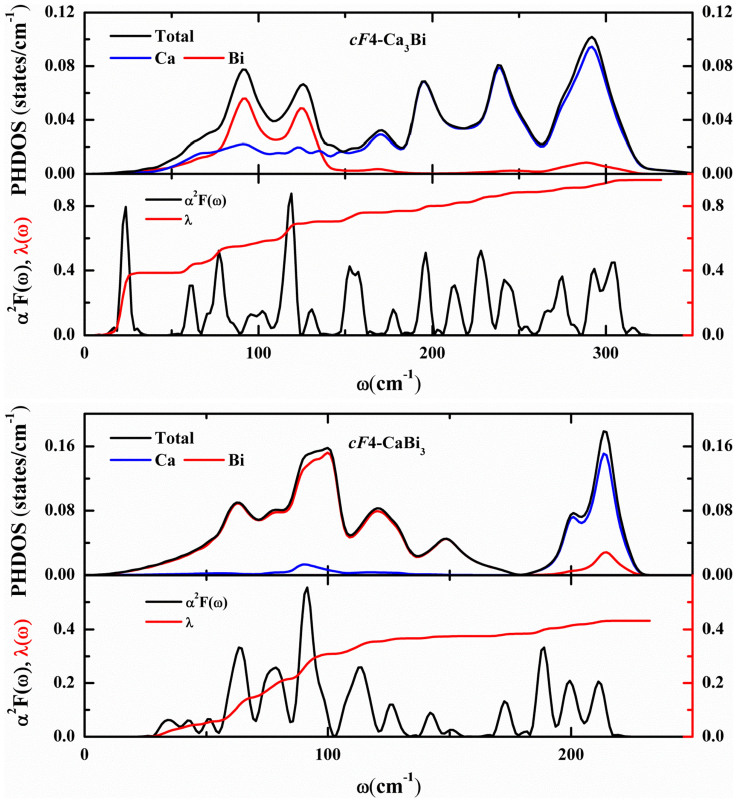
Total and projected phonon density of states (PHDOS) and Eliashberg function α2F(ω) for cF4-Ca3Bi at 60 GPa and cF4-CaBi3 at 30 GPa and the corresponding integrated electron-phonon coupling constant λ(ω).